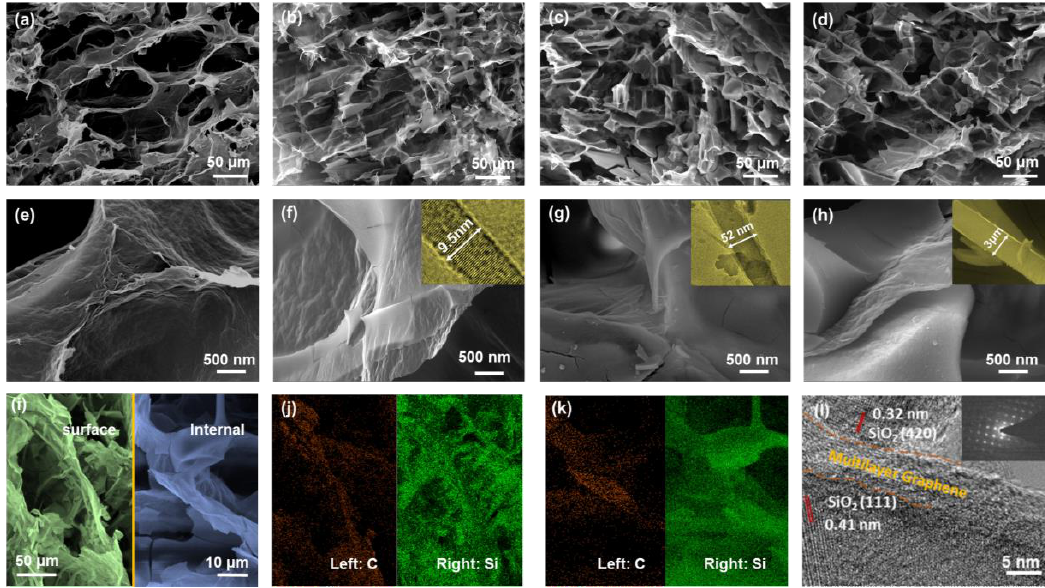
Figure 2. ( a – d ) SEM images of microstructural geometric pattern evolutions for GSAs fabricated by SiO 2 sol concentrations of 0, 5 wt %, 20 wt %, and 30 wt %, respectively. ( e – h ) Morphologies of micronodes presenting different combination formats between graphene sheets and SiO 2 accretions as SiO 2 sol concentrations increased from 0 to 30 wt % (insets in ( f – h ) show thicknesses of SiO 2 layers). ( i ) SEM image of selected area for EDS in GSA-10 (left, surface position; right, internal position). ( j – k ) EDS mapping of elements (left) C and (right) Si. ( l ) TEM image with high-resolution diffraction (inset).